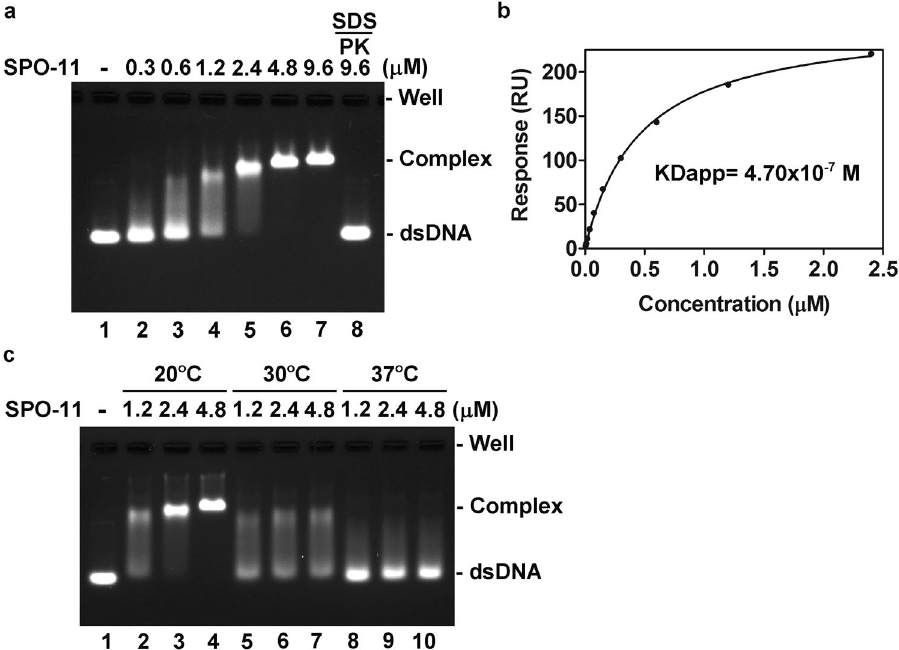
Figure 3. DNA-binding activity in SPO-11. ( a ) The indicated concentration of SPO-11 was incubated with a 100 bp dsDNA. In lane 8, the reaction mixture was treated with proteinase K (PK) and SDS to release the DNA from the nucleoprotein complex. ( b ) The interaction of indicated concentration of SPO-11 with an immobilized 100 bp dsDNA was analyzed by surface plasmon resonance. ( c ) DNA binding activity of SPO-11 is temperature